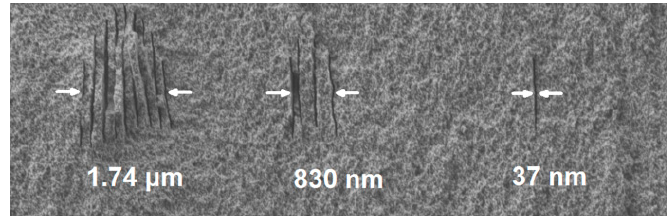
Figure 8. Evolution from nanograting to single nano-sheet with decreasing laser intensity.